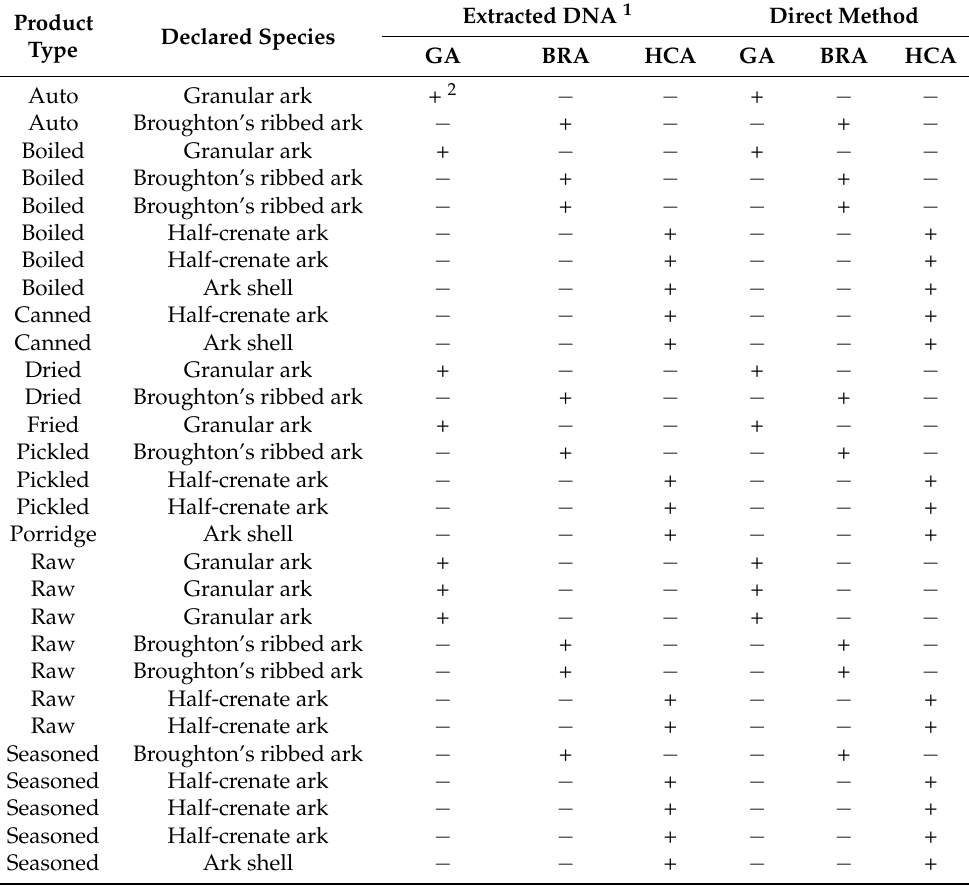
Table 5. Application of the direct ultrafast PCR method for identification of ark shell species in commercially processed